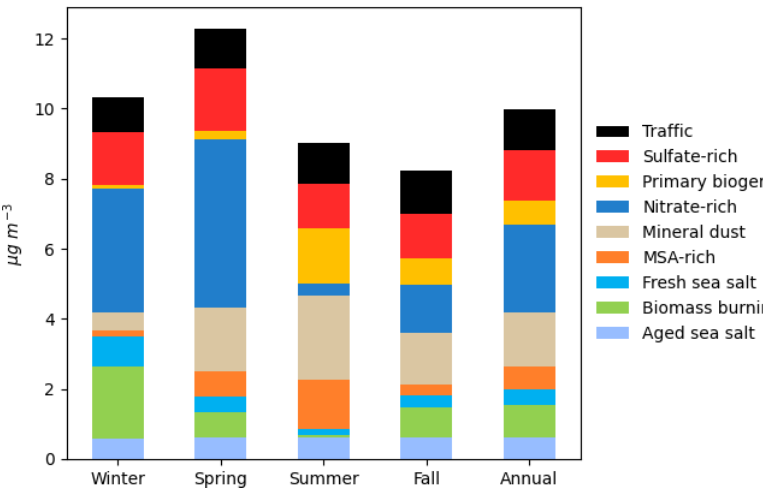
Figure 4. Seasonal and annual contribution of the PMF-resolved sources at the OPE